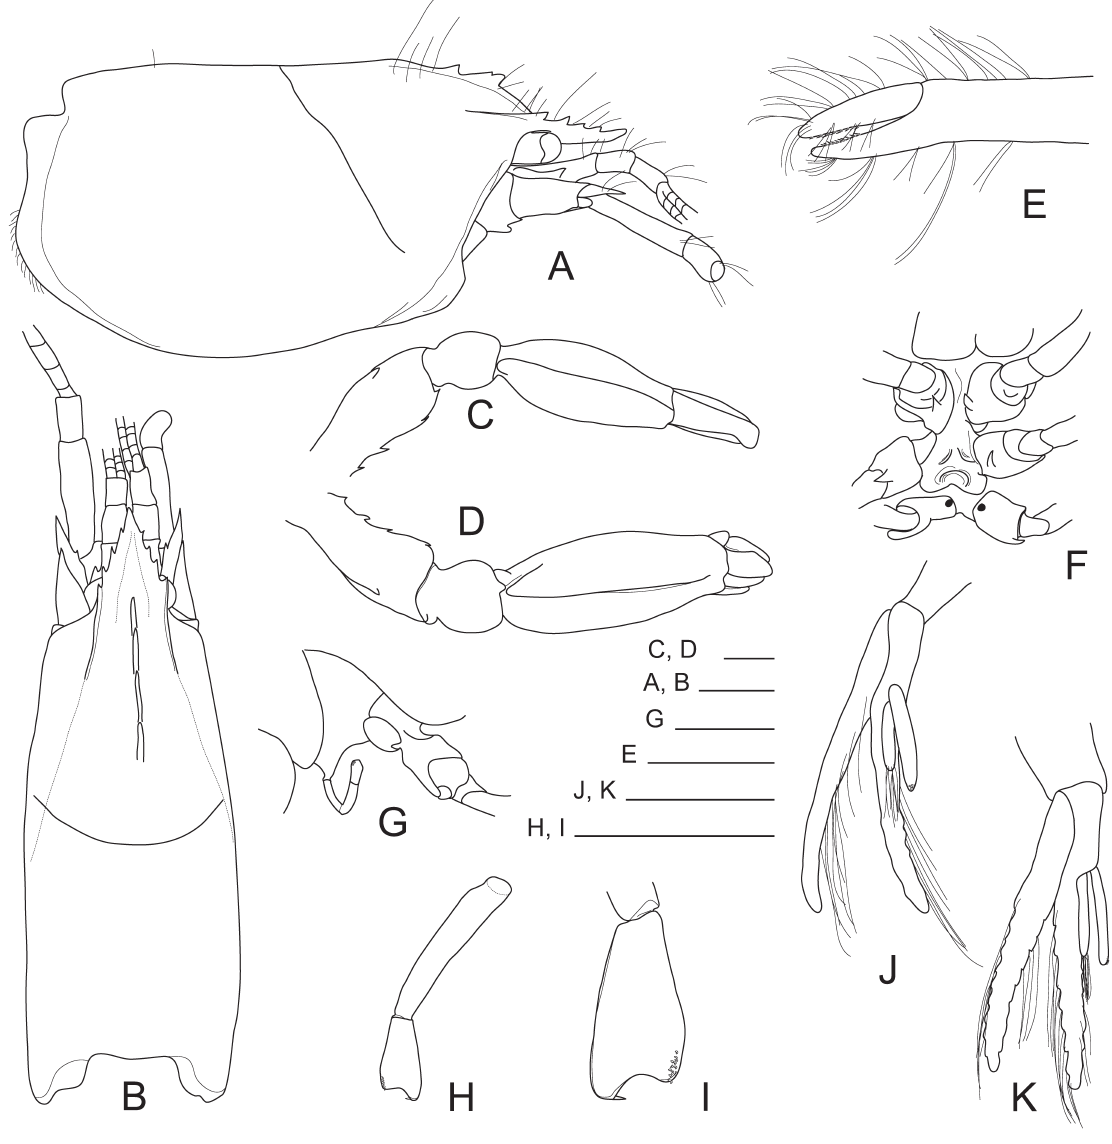
Fig. 1. Montanaxius mediumquod gen. et sp. nov., holotype, ♂, NHMW 25677. A . Carapace in lateral view. B . Same, dorsal view. C . Minor cheliped in dorsal view. D . Major cheliped in dorsal view. E . Tip of pereopod 2. F . Sternites 6–8. G . Ventral part of coxa 5 and pleomere 1 with Plp1 (first article bent) in lateral view. H . Left Plp1 in anterior view. I . Terminus of left Plp1, posterior view. J . Left Plp2, mesial view. K . Right Plp2, anterior view. Setation omitted in C and D. Scale bars: A–H, J–K = 1 mm; I = 500